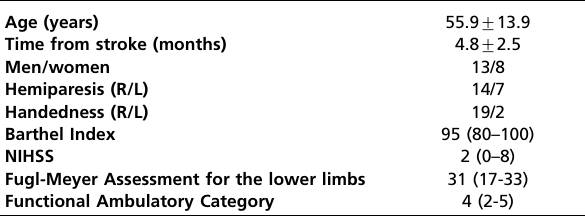
Table 1 - Characteristics of the